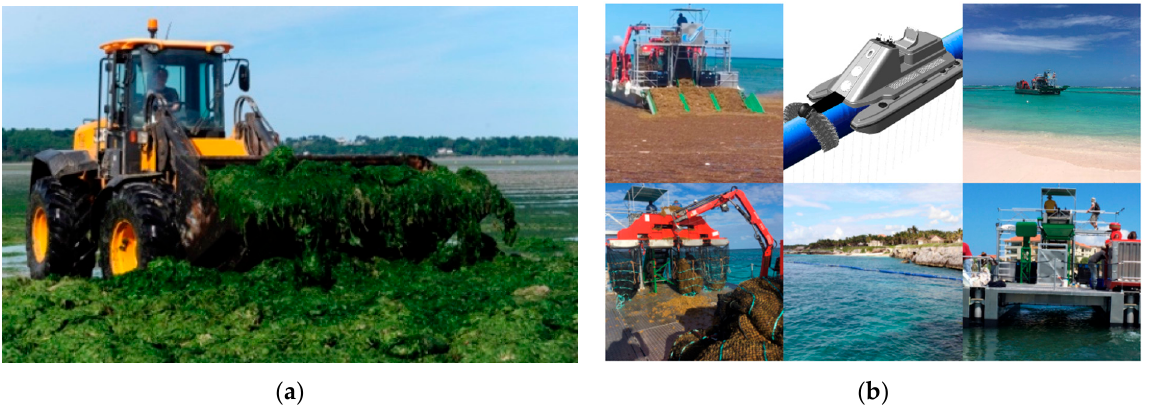
Figure 3. ( a ) Seaweed harvesting in Britany, France. ( b ) Sargassum harvesting by Algenova in the Dominican Republic.